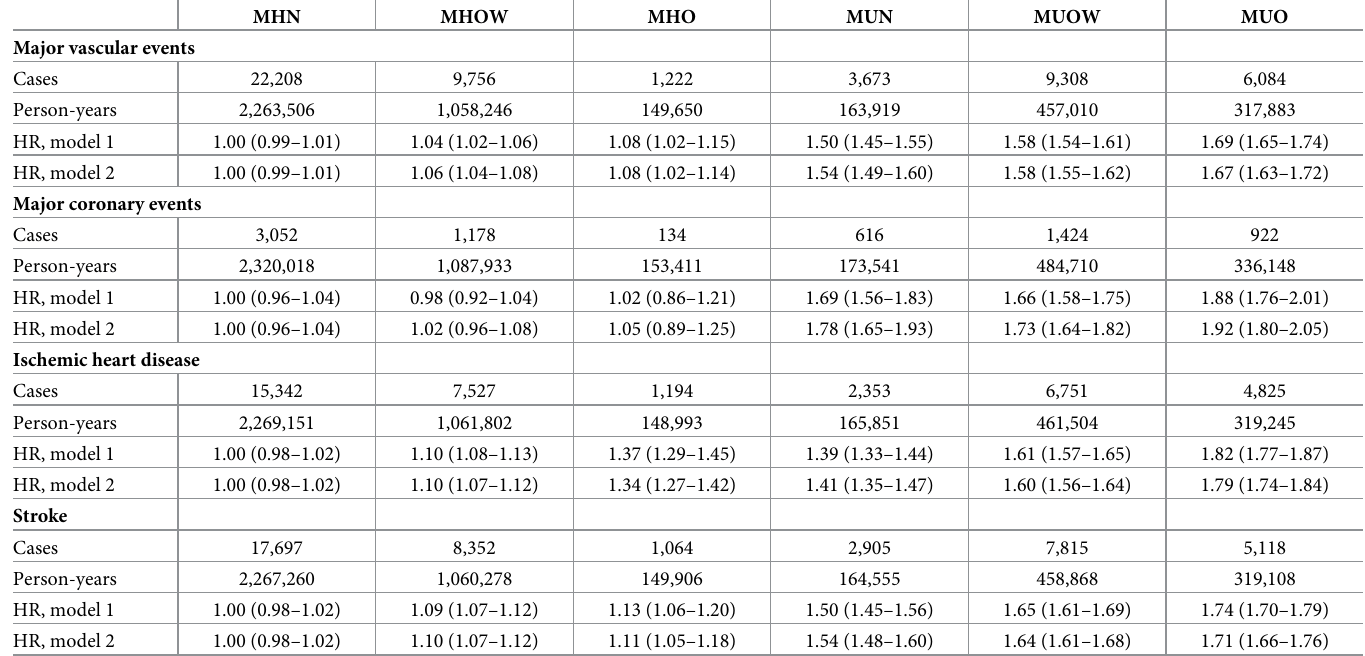
Table 2. Adjusted HRs for vascular diseases by BMI-metabolic health status at baseline.